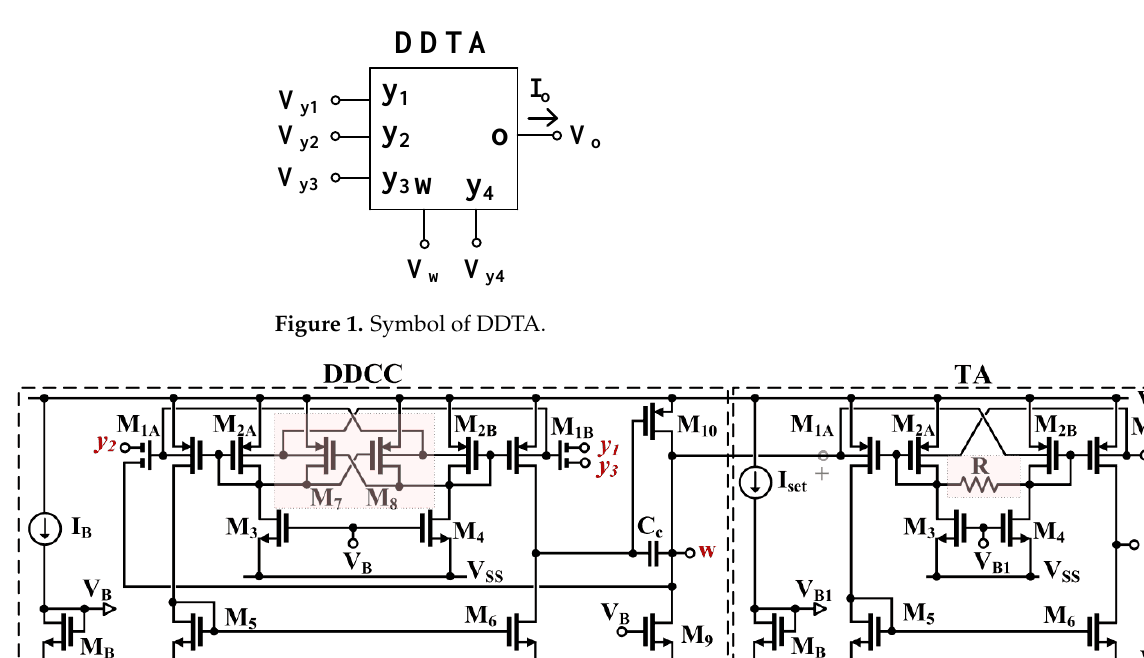
Figure 2. Proposed CMOS structure of DDTA.